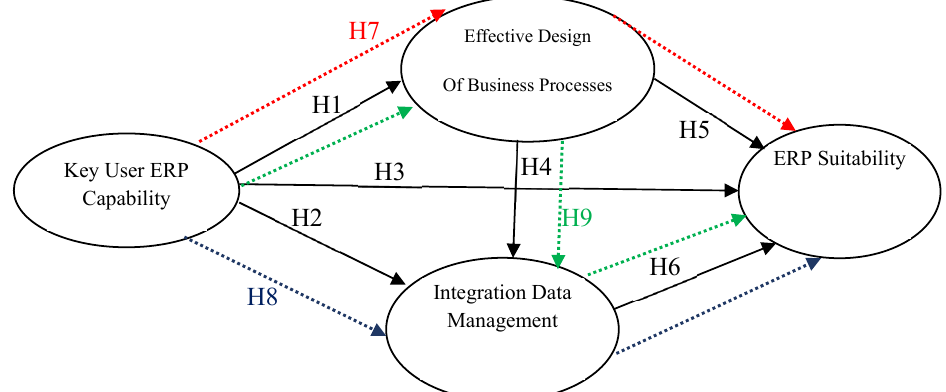
Fig. 1. The conceptual framework and research